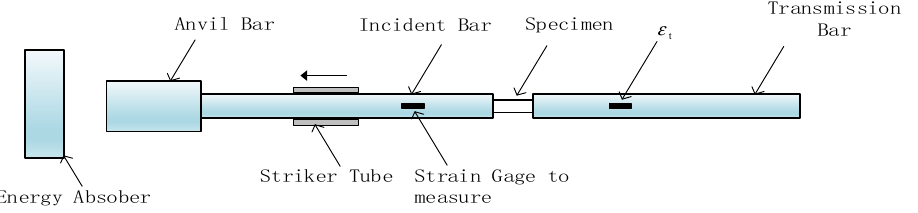
Figure 7. Set-up of Hopkinson tensile bar system.